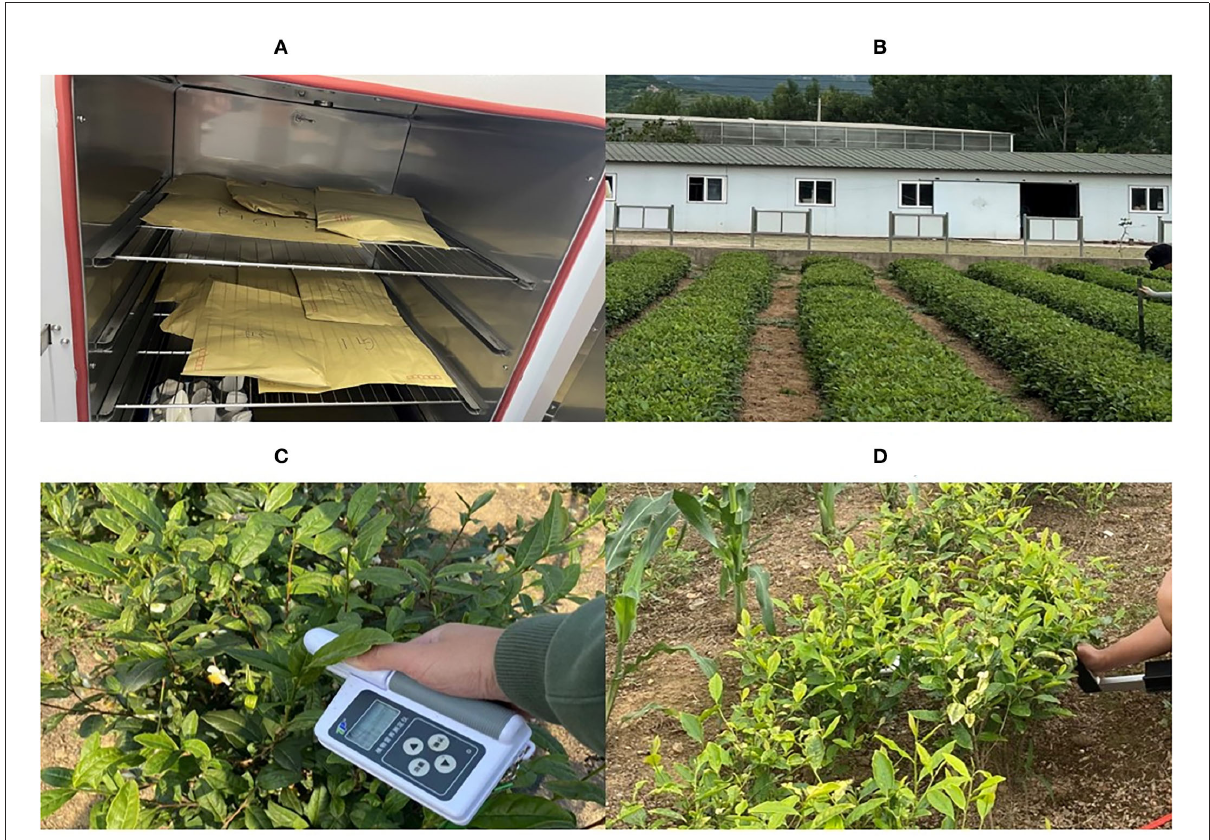
FIGURE2 (A) Determination of the W; (B) determination of the H; (C) determination of the LCC and LCN; (D) determination of the LAI.